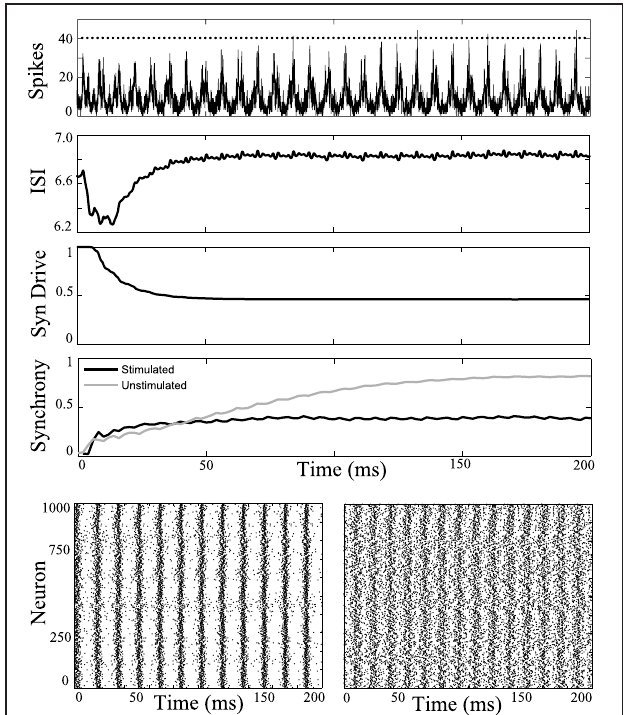
FIGURE 5 | Desynchronizing the clonic phase. Computational simulation of network activity with current set to − 2nA to simulate clonic phase of seizure. See Figure 3 for general figure description. Synchrony of the unstimulated clonic network increases to a strong value near 0.8 (gray). When applying the 2ms periodic DBS pulse, the network activity is desynchronized. Bottom Left, unstimulated cells have high synchrony. Bottom Right, network stimulated with 2ms pulses. Less synchronous activity is observed in the stimulated network.